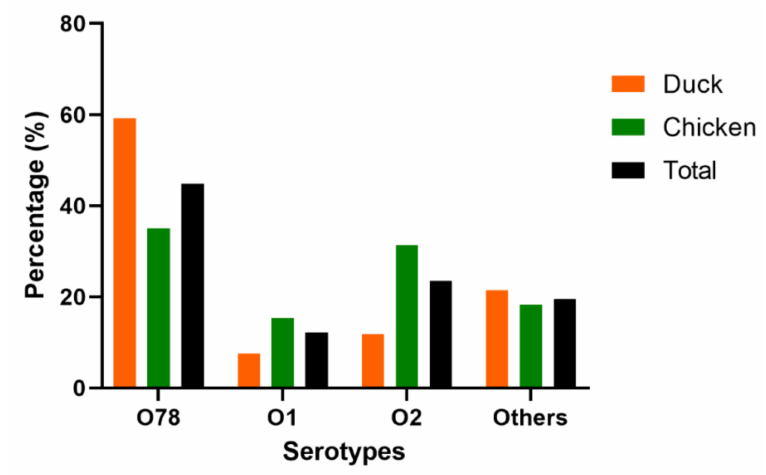
Figure 1. The serotypes of 230 APEC isolates from chickens ( n = 137) and ducks ( n = 93). Bar charts show the serotypes distribution of APEC isolated from chicken (green), duck (orange) and total (black).